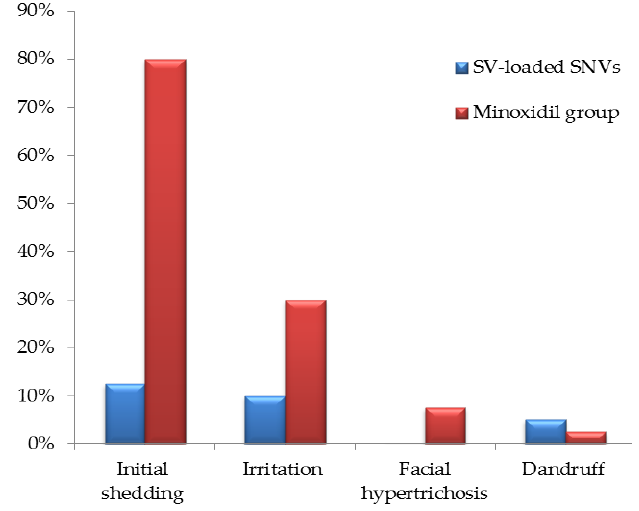
Figure 14. Analysis of the side effects in the cases of the study for SV-loaded SNVs ( n = 40) and minoxidil ( n = 40) groups. Abbreviations: SV, Sodium valproate; SNVs, spanlastic nanovesicles.